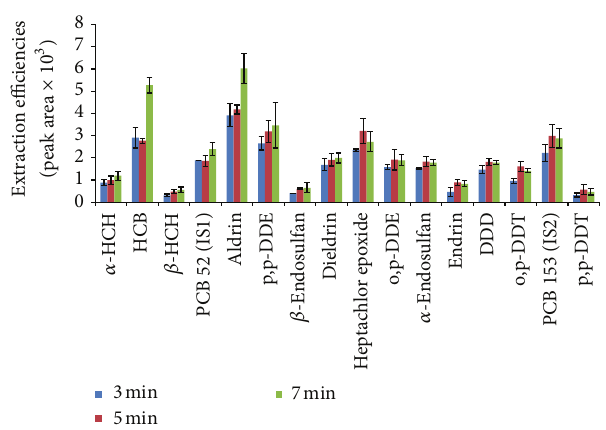
Figure 6: Effect of desorption time of 14 organochlorine pesticides on their extraction